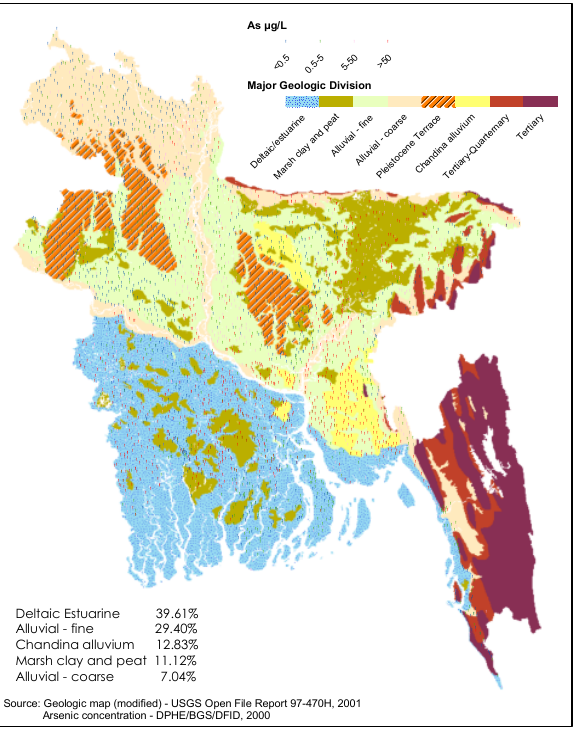
Figure 2: Geologic units and arsenic concentrations in groundwater in Bangladesh [7,